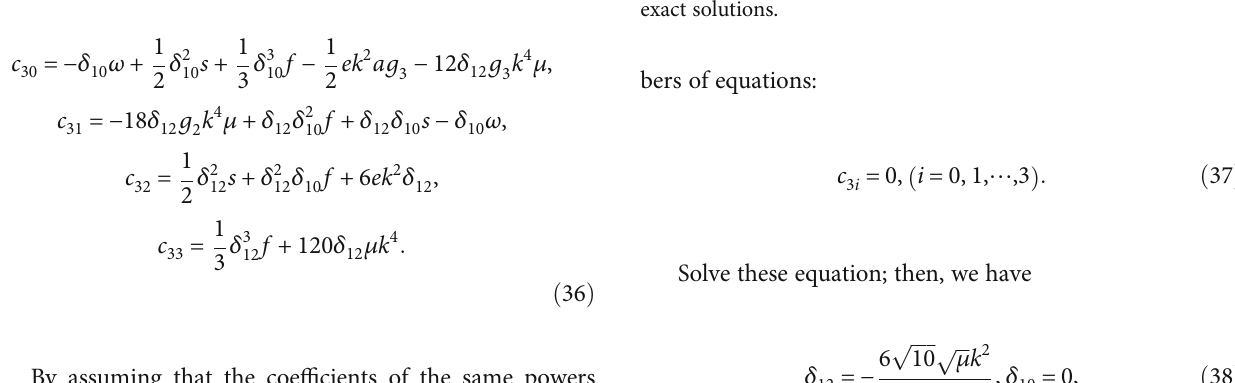
ð z Þ for the fi xed r ,1 Figure 4: Perspective view of 3D graph of W values ω = 9 , z 0 = − 1/6 , μ = 1 , k = 1 , f = 1 , and α = 1 represents the exact